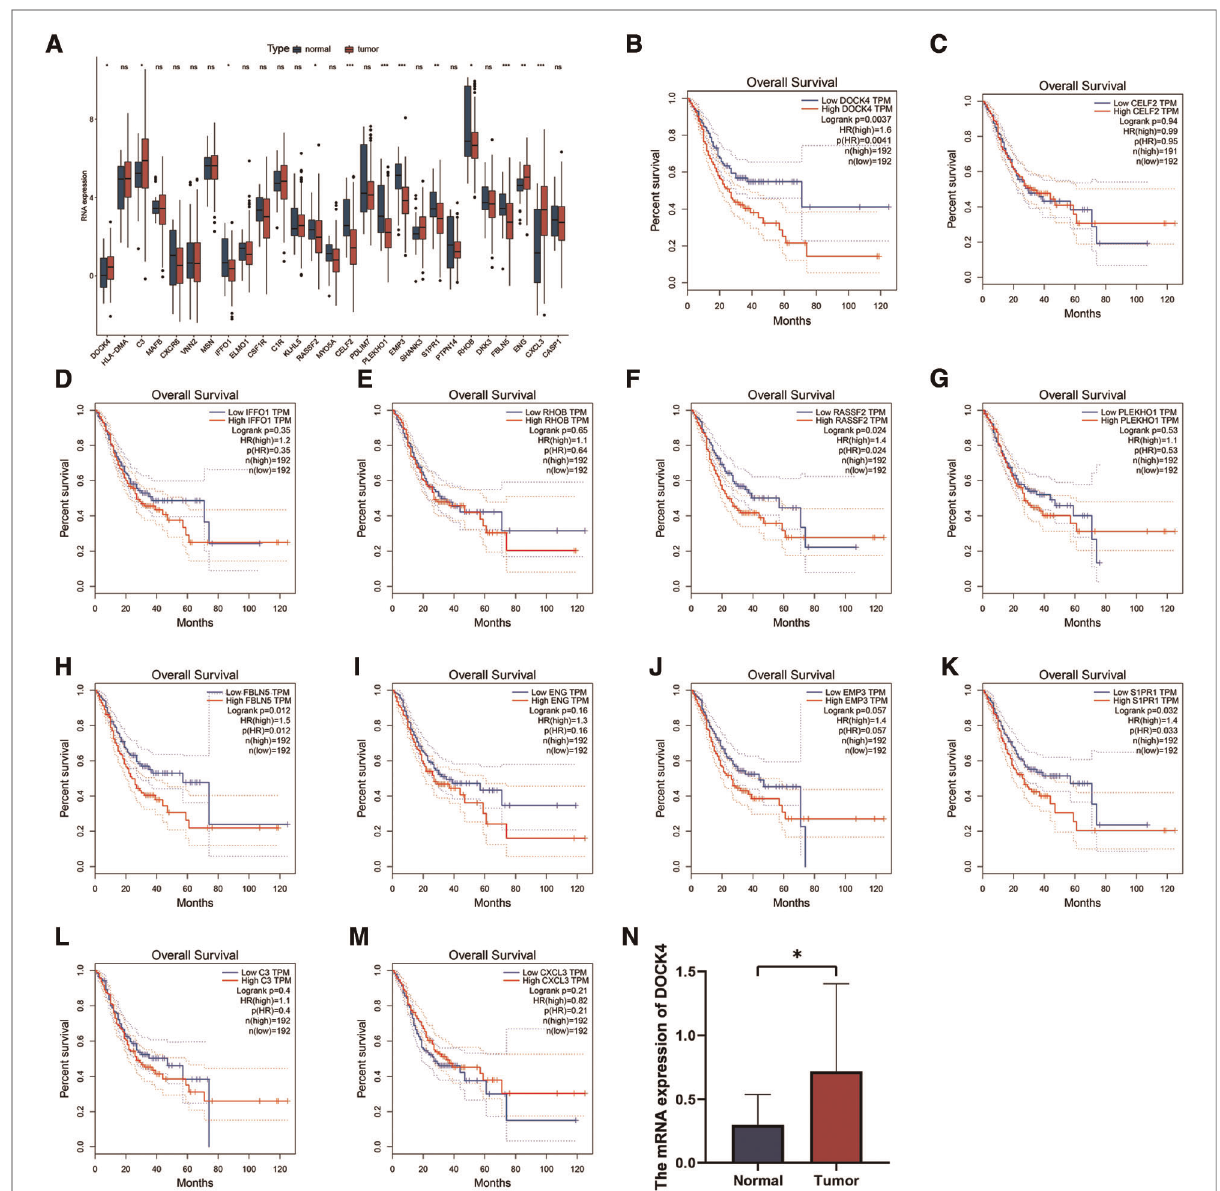
FIGURE 8 Expression and validation of 28 HP-related prognostic genes. ( A ) The expression patterns of 28 HP-related prognostic genes were analyzed in the TCGA-STAD cohort. ( B – M ) Analysis of overall survival with HP genes high and low expression groups in TCGA-STAD cohort. ( N ) qRT-PCR analysis of the expression of DOCK4 in 29 normal and 24 tumor tissue